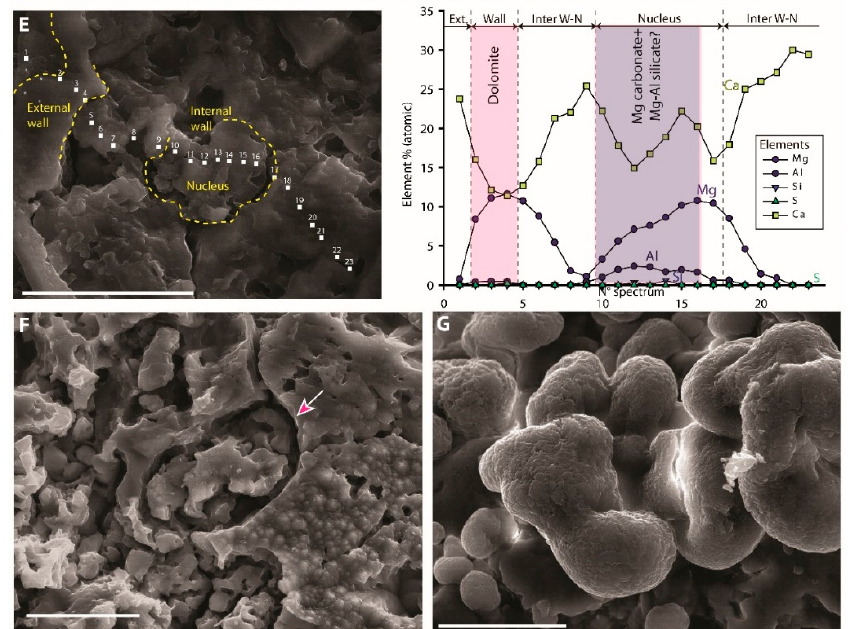
Figure 17. Selected microbial microstructures (Table 2) observed under SEM (secondary electron mode). In ( A – D ), the detail of isolated (( A – C )) or double (( D )) microspheres, interpreted as fossilized coccoid cells. The outer wall is composed of dolomite, while the inner wall shows enrichment in Mg, Al, and Si that are interpreted as remnants of Mg-Al silicates. The alveolar structure surrounding cells (( B ); yellow arrow) could correspond to former exopolymeric substances (EPS). The scale bars are 20 µ m. ( E ) To the left, the position of an EDS transects a microsphere (same sample as ( A – D )). The scale bar is 7 µ m. To the right, the evolution of Mg, Al, Si, S, and Ca content along this transect. The microspheres have two walls. The external wall is massive with internal expansions and is composed of dolomite. The internal wall is thinner, less regular (see ( A – D )), and delineates a nucleus enriched in Al, Si, and S, possibly related to the presence of Mg-Al silicate remnants mixed with Mg carbonates. ( F ) Bean-shaped structure (pink arrow), interpreted as the mold of a former filamentous cyanobacteria sheath (Table 2). Stromatolitic crust (Cr1; Table 1), Cariatiz, DS4. The scale bar is 10 µ m. ( G ) Dolomite microballs and dumbbells. The scale bar is 10 µ m. Stromatolitic crust (Cr1; Table 1), Cariatiz, DS4. The scale bar is 40 µ m.